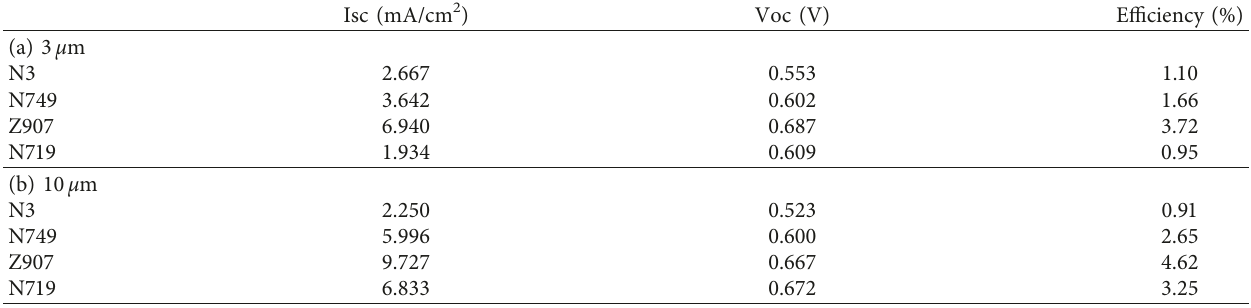
Table 1: Short-circuit current density, open-circuit voltage, and efficiency of devices fabricated with (a) 3 μ m and (b) 10 μ m mesoporous TiO 2 films using dyes N3, N749, Z907, and